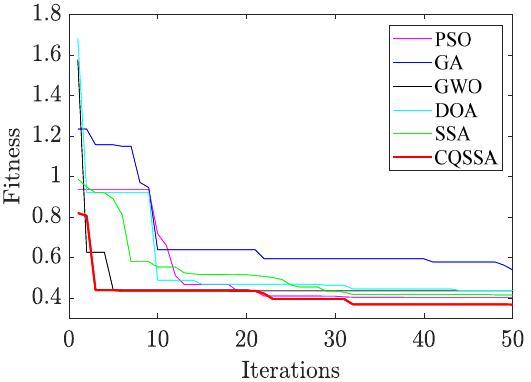
Figure 6. The convergence characteristics of six algorithms under HPPC test.